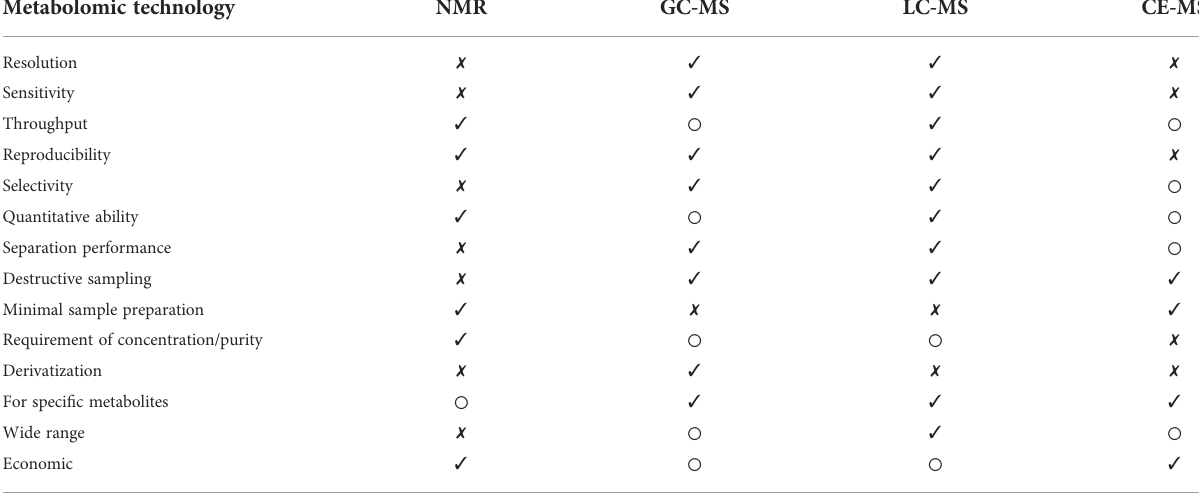
TABLE 1 Comparison of different metabolite